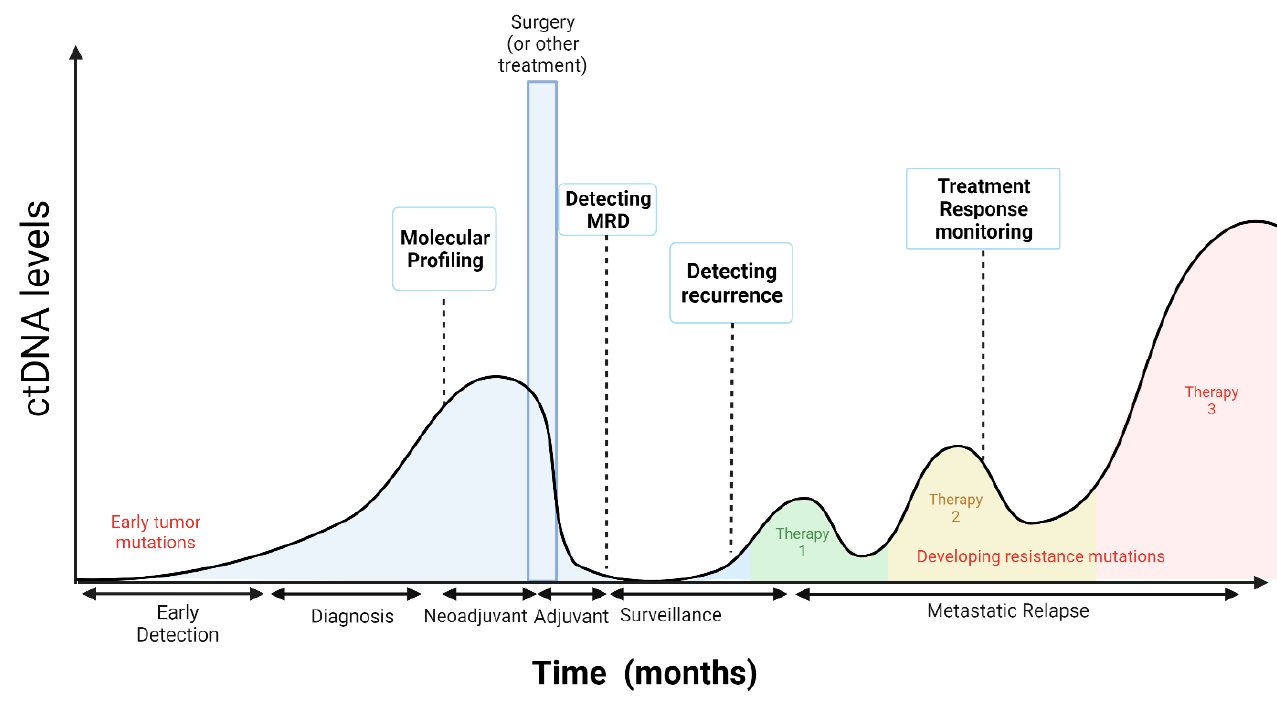
Figure 2. Potential applications of ctDNA detection assays in early and late stages of solid tumors. Adapted from Wan et al. [25]. Created with BioRender.com.